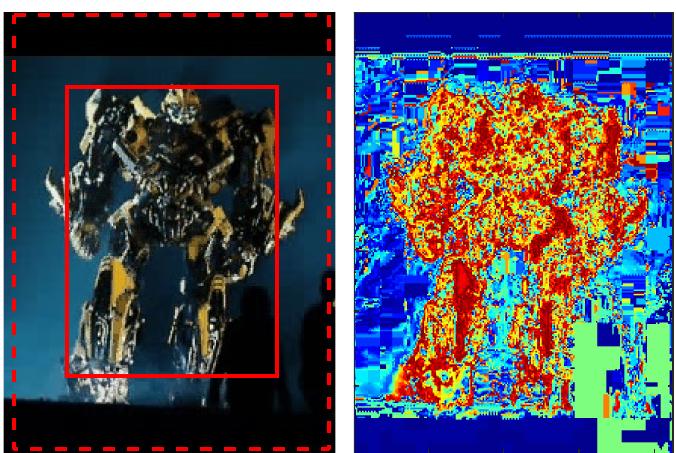
Figure 4. Exemplary object likelihood map for the discriminant model illustrating the object region O and surrounding region S .